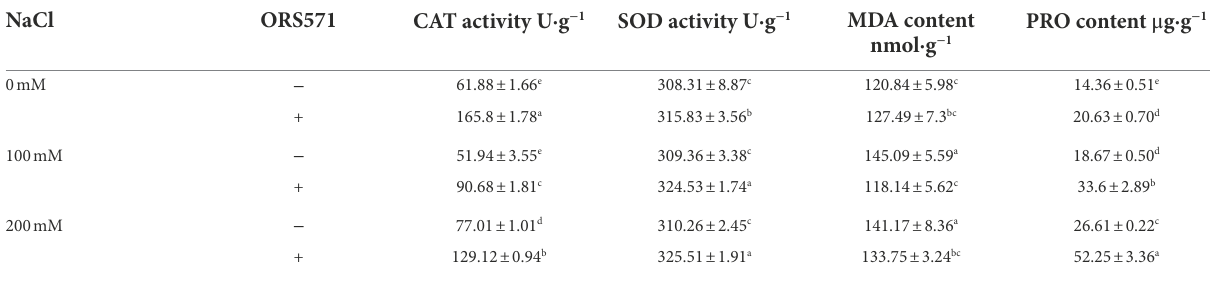
TABLE 1 Effect of ORS571 on CAT, SOD activity and MDA, PRO content in leaves under salt stress.